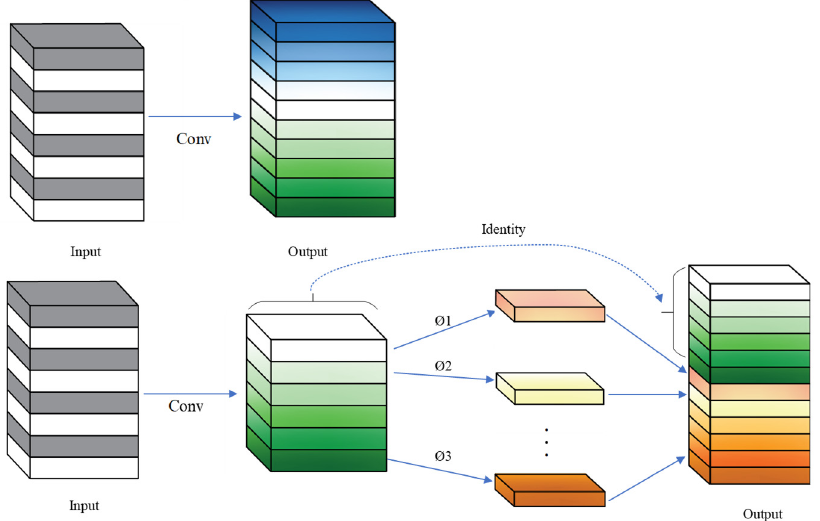
Figure 2. Traditional convolution and Ghost Module convolution. The green and blue layers represent the feature maps obtained by traditional convolution, and the yellow layers represent the feature maps obtained by cheap operation.